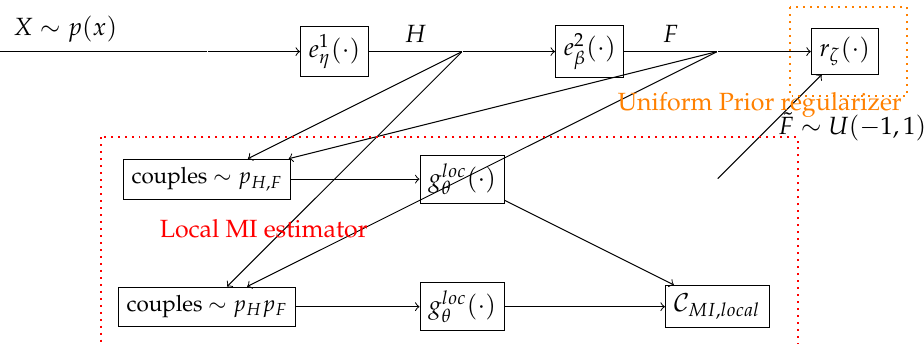
Figure 4. Detailed representation of high level scheme depicted in Figure